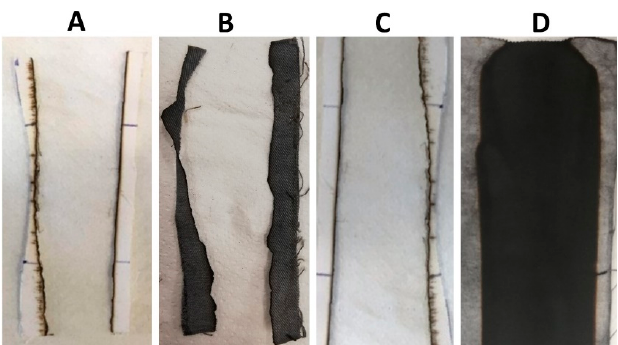
Figure 10. Residues after vertical flame spread tests performed on washed fabrics. ( A ) COT, ( B )